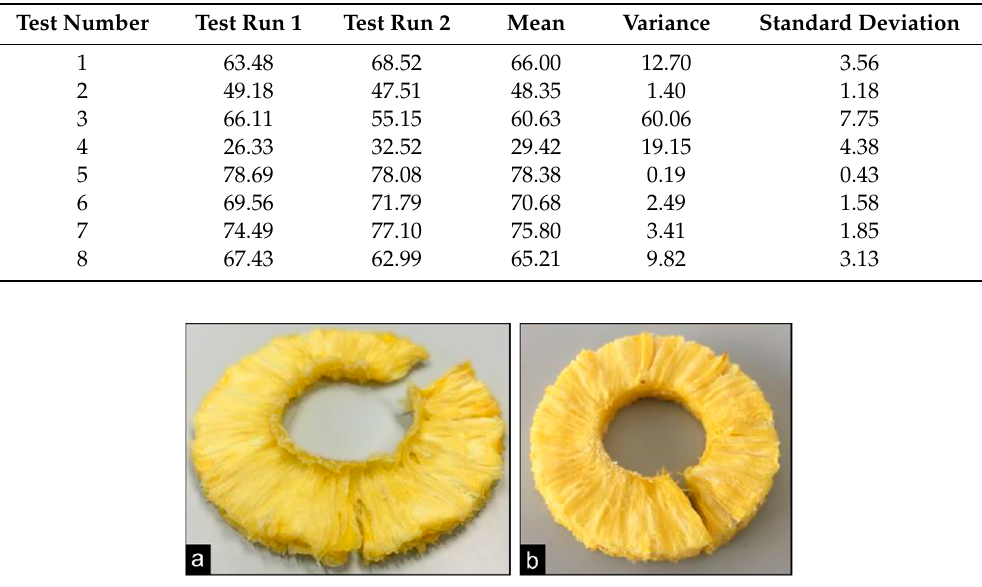
Figure 6. Visual comparison of the dried pineapple slices obtained using ( a ) the best combination of input factors and ( b ) the worst combination of input factors .